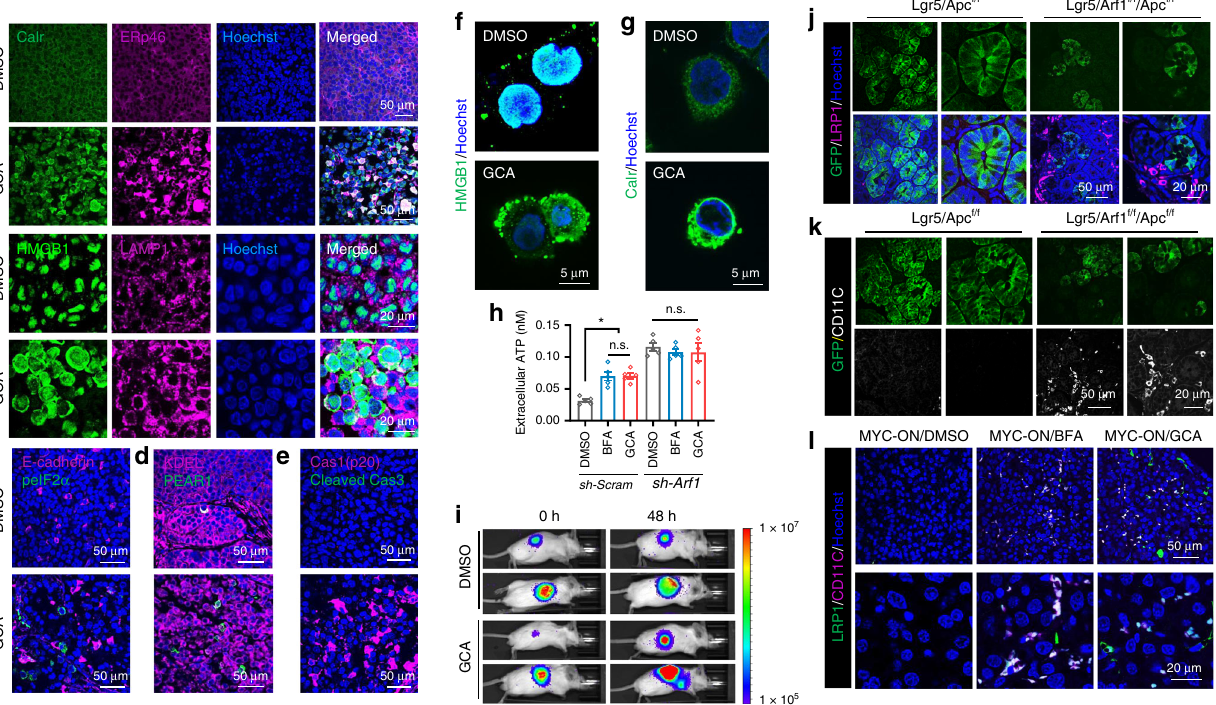
Fig. 5 Arf1 inhibition triggers ER stress and induces DAMPs and DC in fi ltration. a – e Huh-7 cells were treated with control DMSO or GCA and then injected into athymic nude mice. After 3 weeks, the tumors from the treated cells were excised and stained for molecular markers. Calr, HMGB1, ERp46, and the lysosome protein LAMP1 were dramatically induced in the GCA-treated tumors ( a and b ). Nuclear HMGB1 moved to the extracellular space ( b ). The ER stress marker peIF2 α and the ERp46 receptor PEAR1 were also signi fi cantly increased in GCA-treated tumors ( c and d ). Cleaved and active Caspase 1 p20 but not cleaved Caspase 3 was also dramatically induced in the GCA-treated tumor ( e ). f , g Direct treatment of Huh-7 cells with GCA induced the expression and translocation of HMGB1 ( f ) and the translocation of Calr ( g ) from the nucleus to the extracellular space. h Treatment of Huh-7 cells with the Arf1 inhibitor BFA or GCA induced ATP secretion from control but not Arf1 (sh-Arf1) knockdown cells ( n = 5 wells cell each group, * p < 0.05, t -test; repeat three independent experiments). i Treatment of mice with Arf1 inhibitor GCA increased ATP release in vivo. j , k LRP1 and CD11c expression in the intestine of Lgr5/Apc or Lgr5/Arf1/Apc mice. l LRP1 and CD11c expression in the liver of MYC-ON liver tumor mice treated with the indicated reagents. Each experiment replicates three times. Data are shown as the mean ± /SEM. * p < 0.05, ** p < 0.01 by Student ’ s t -test. Scale bars are as